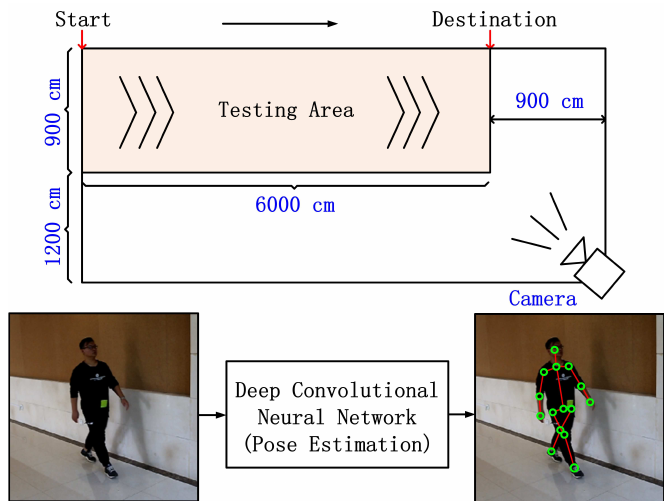
Figure 6. Overview of the capture system and the captured images. The top is the testing field of our database, and the bottom is one frame in a single gait sequence of our database, which is captured from the prescribed walking